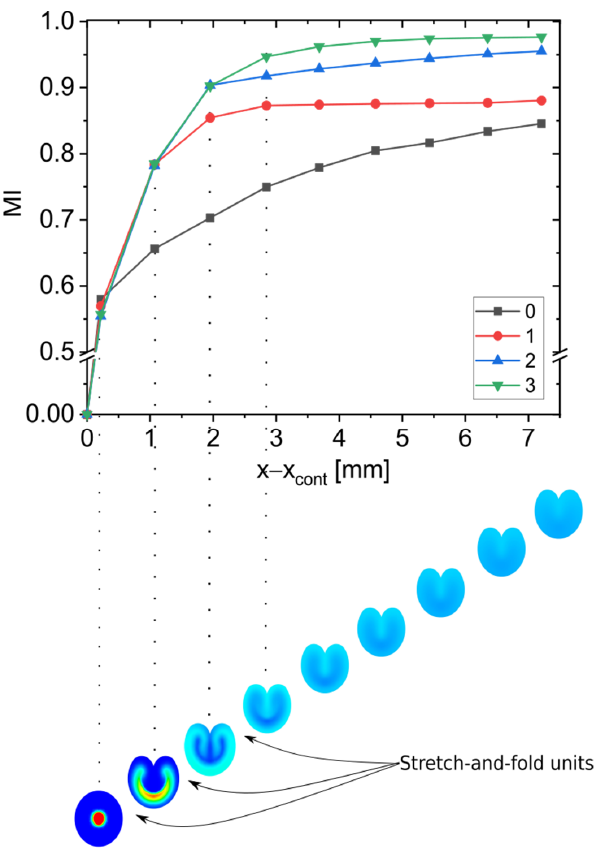
Figure 5. MI versus the positions in flow direction at a total flow rate of 36 µ L/min with a 10% flow rate ratio for a varied number of stretch-and-fold units. The color of data points indicates the number of stretch-and-fold units. The investigated planes with exemplary concentration fields are indicated below the diagram to indicate their position together with the positions of the stretch-and-fold units. As in Figure 4 the concentrations of ethanol resulting from convection and diffusion are shown, while in earlier work [34], only the streamlines (representing only convection but not diffu ‐ sion) were given.